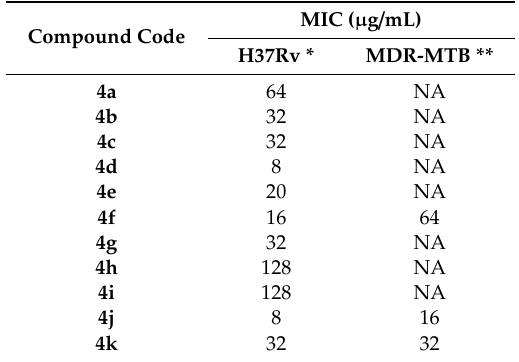
Table 1. Antitubercular activity of ethyl 1-(substituted benzoyl)-5-methylpyrrolo[1,2- a ]quinoline-3- carboxylate 4a – f and dimethyl 1-(substituted benzoyl)-5-methylpyrrolo[1,2- a ]quinoline-2,3-dicarboxylate 4g – k analogues against H37Rv and multidrug-resistant (MDR)– Mycobacterium tuberculosis (MTB) strains of Mycobacterium tuberculosis .